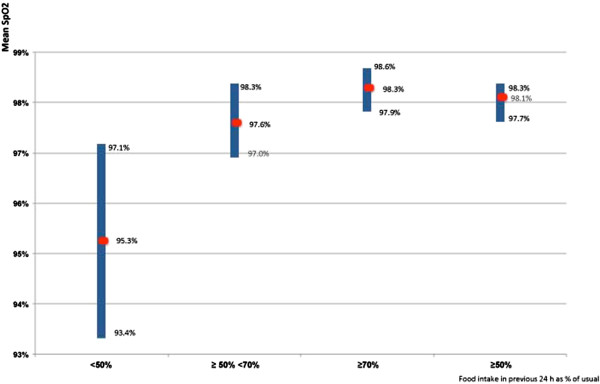
Mean SpO2values according to food intake in the previous 24 h (as a percentage of usual intake). The three left-hand rectangles show that mean SpO2 values vary in the same direction as 24 h % food intake. The first and last rectangles show the significant difference in mean SpO2 values between infants who took < 50% or ≥ 50% of their usual volume of food in the previous 24 h (4 missing data). Length of the rectangles according to the 95% confidence intervals.